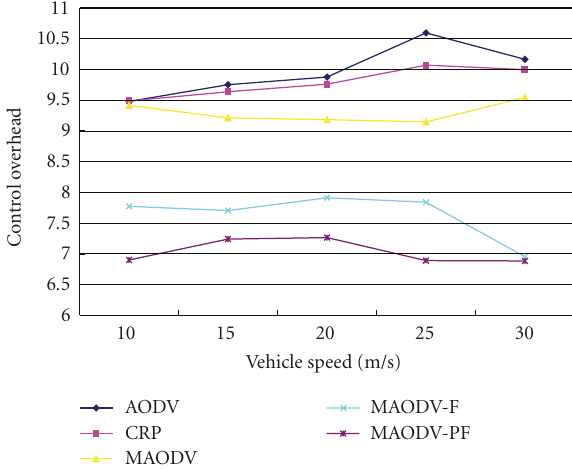
Figure 7: Packet delivery ratios for CRP, AODV, MAODV, MAODV-F, and MAODV-PF under di ff erent moving speeds.